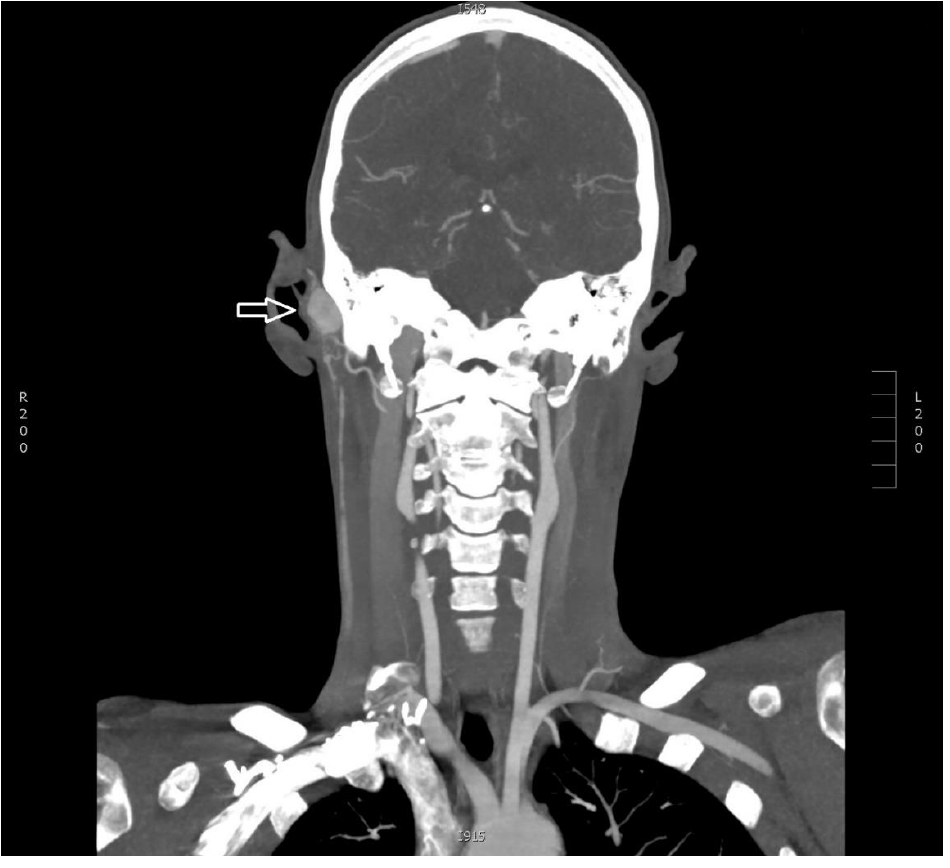
Figure 2. Coronal maximum intensity projection (MIP) with multiplanar reconstruction (MPR) showing the right-sided contrast-enhancing tumor (arrow) supplied by arterial branches from the right external carotid artery and with surrounding veins draining into the right external jugular vein.